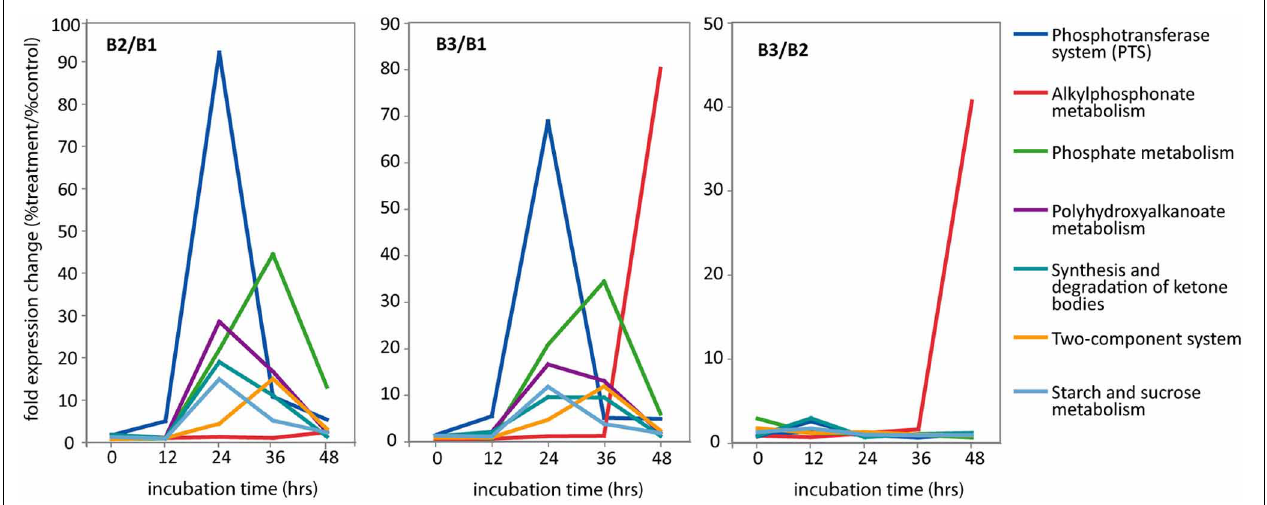
FIGURE 6 | Relative abundance of selected KEGG pathways in metatranscriptomic datasets. For each time point, abundance is expressed as fold expression change relative to the no amendment control (% treatment/%control). Left panel (B2/B1): Glc + N/no amendment control;